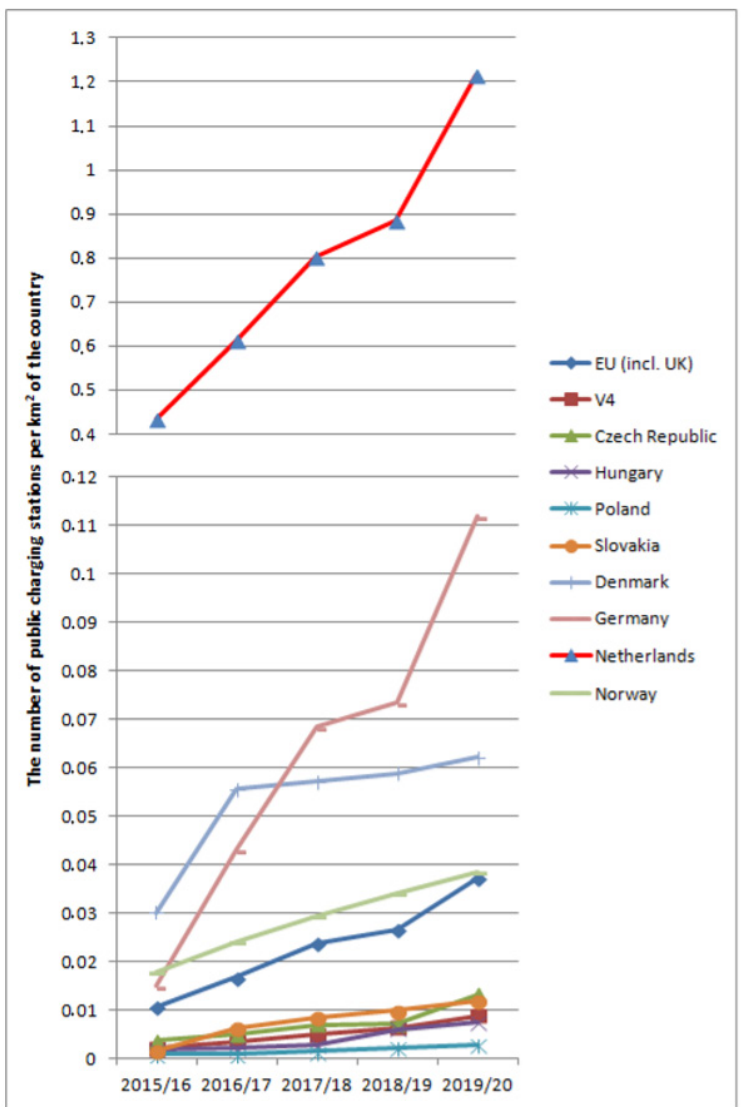
Figure 5. The development of the parameter N k (the number of public charging stations per km 2 of the country).